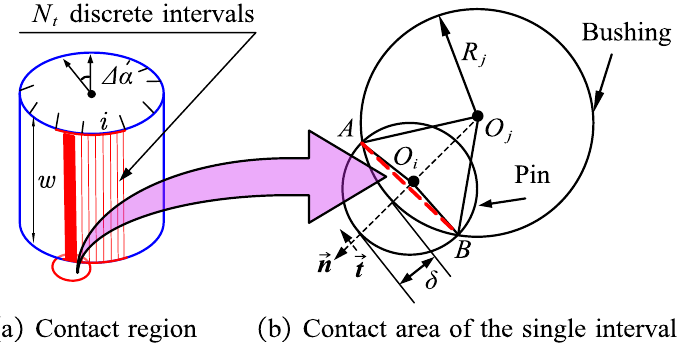
Figure 5. Calculation of equivalent contact area when pin and bushing have contact.